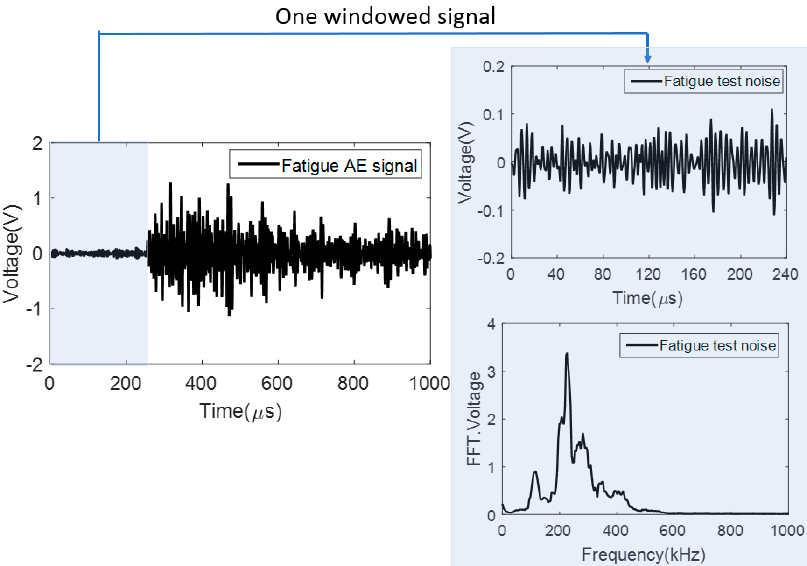
Figure 6. The window to obtain the operational noise frequency of the UIC fatigue test. Table 2. The summary of Acoustic Emission (AE) features.